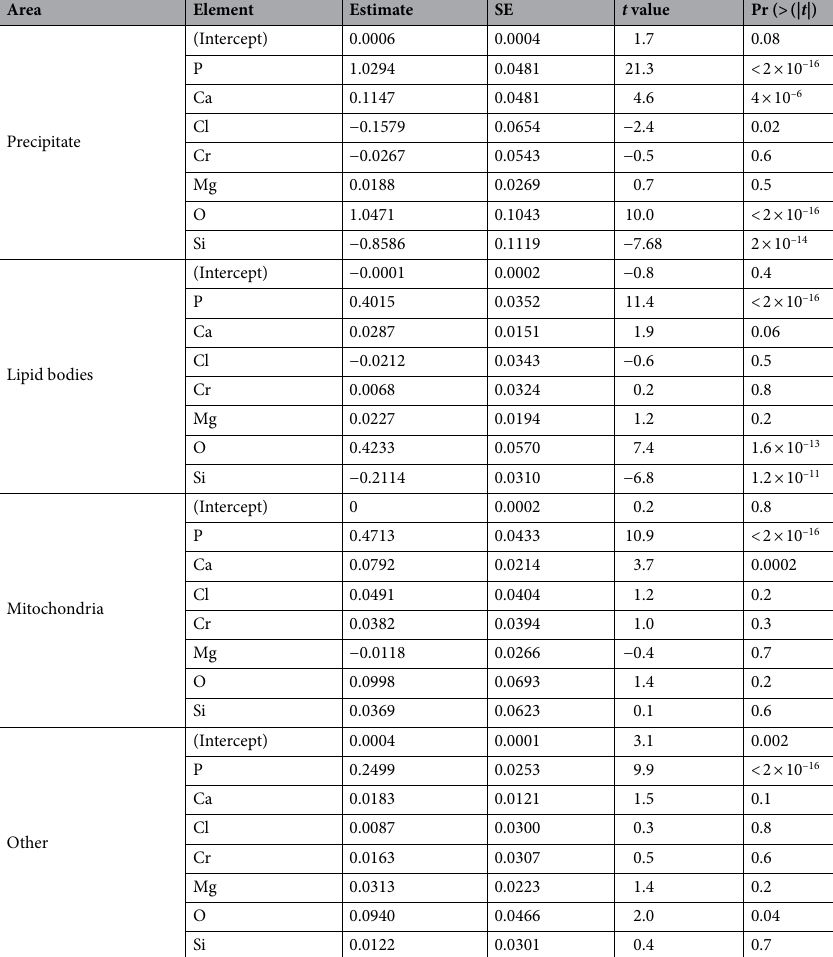
Table 2. Model 1 multivariable linear regression*. *Model 1 was Gd ~ P + Ca + Cl + Cr + Mg + O + Si. Residuals (minimum, median, and maximum) for precipitate, lipid-rich bodies, mitochondria, and other were −0.007, −0.0005, 0.0144; −0.004, −0.0003, 0.0158; −0.004, −0.0001, 0.007; and −0.004, −0.0003, 0.01, respectively. Residual standard of error for electron-dense precipitates was 0.003 on 2265 degrees of freedom, multiple r 2